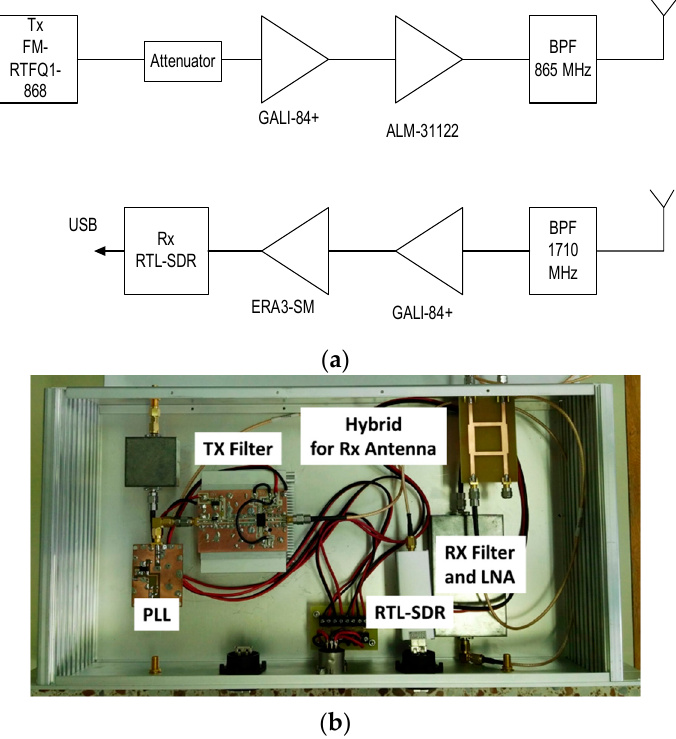
Figure 15. Block diagram ( a ) and photography ( b ) of the low-cost reader implemented.